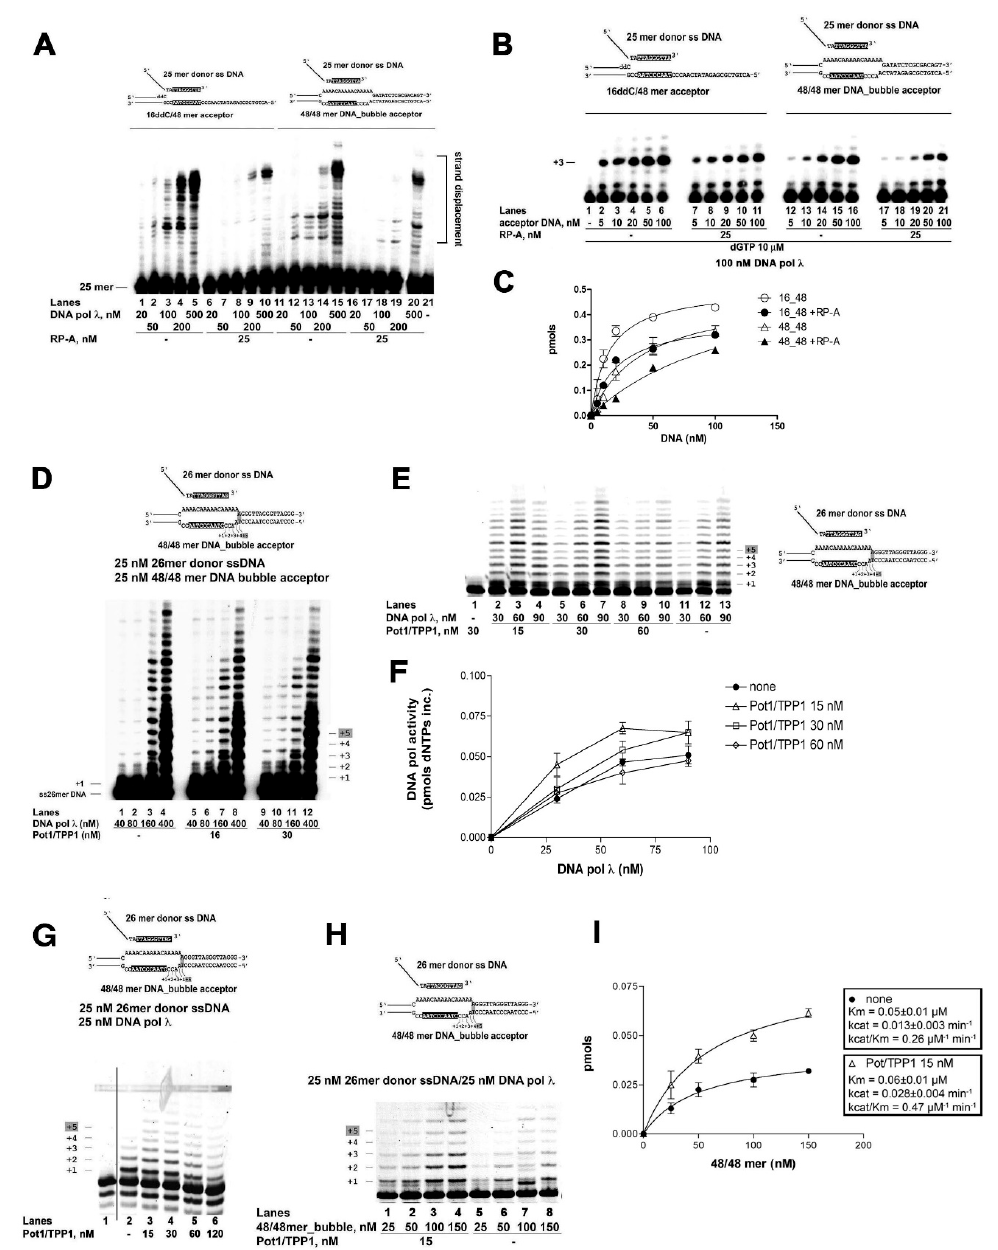
Figure 4. Microhomology ‐ mediated strand transfer and DNA synthesis by DNA polymerase λ on telomere sequences is regulated by RP ‐ A and POT1/TPP1. DNA templates are shown on top of each panel. Black boxes indicate the annealing site on the 5 ′‐ labelled primer and template strands. ( A ) Titration of Pol λ alone (lanes 1–5; 11–15) or in combination with 25 nM RP ‐ A (lanes 6–10; 16–20), in the presence of the 16/48 linear (lanes 1–10) or the 48/48 “bubble” (lanes 11–20) acceptor DNA templates. ( B ) Titration of dideoxy ‐ terminated 16/48mer (lanes 2–11) or 48/48mer “bubble” (lanes 12–21) acceptor DNA templates, in the presence of dGTP and in the absence (lanes 2–6; 12–16) or in the presence (lanes 7–11; 17–21) of 25 nM RP ‐ A. ( C ) Dose ‐ response curves of nucleotide incorporation (pmols) by Pol λ in the absence (clear symbols) or pres ‐ ence (filled symbols) of 25 nM RP ‐ A on the linear (circles) or bubble (triangles) substrates illustrated in panel B. Values are the mean of two measurements ± S.E. ( D ) Titration of Pol λ on the 48/48mer “bubble” template, in the absence (lanes 1–4) or in the presence (lanes 5–12) of different amounts of the POT1/TPP1 complex. ( E ) Titration of Pol λ on the 48/48mer